Question: Generate an informative caption for the figure above.
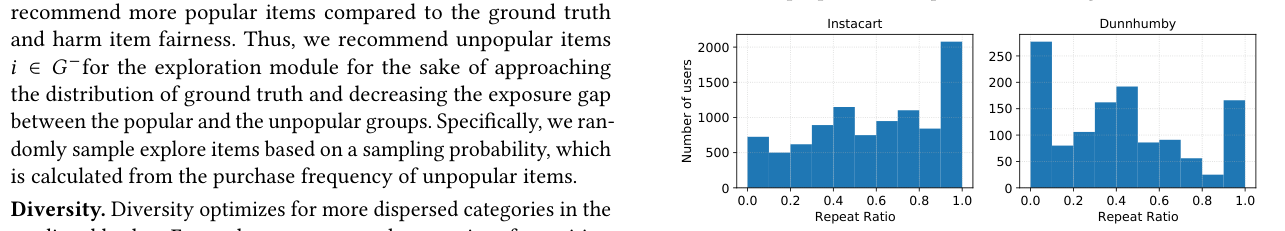
Answer: Distribution of users across different repeat ratios for Instacart and Dunnhumby.